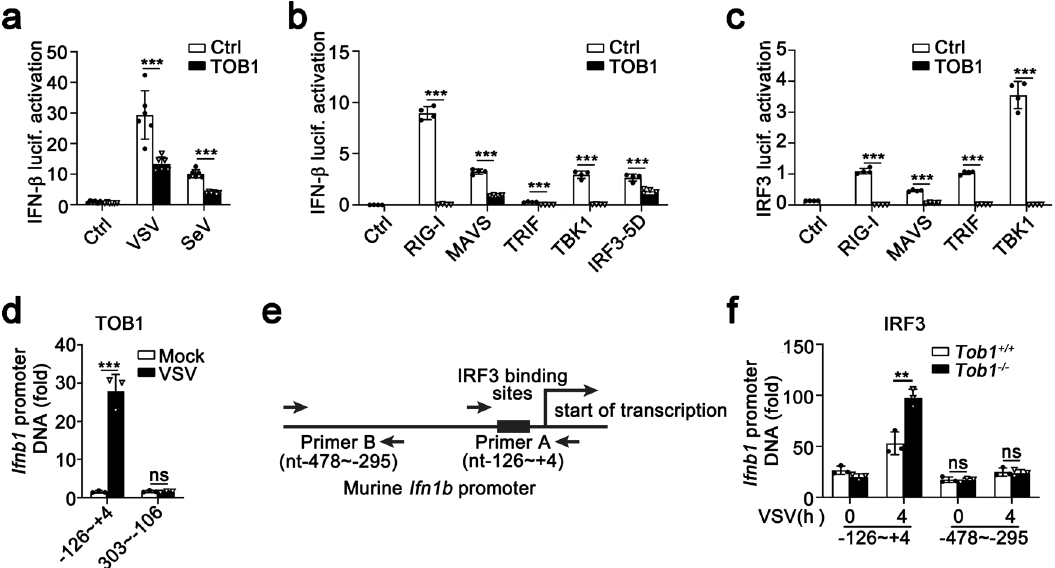
Fig. 4 TOB1 inhibits IRF3 binding to Ifnb1 promoter. a Luciferase activity analysis of HEK293T cells transiently transfected with IFN- β reporter plasmid together with TOB1 expression plasmid or empty vector(ctrl) after being infected with VSV or SeV. b , c Luciferase activity analysis of HEK293T cells transiently transfected with IFN- β ( b ) or IRF3 ( c ) reporter plasmid and adaptor plasmids as indicated, together with TOB1 expression plasmid or empty vector(ctrl). d ChIP-qPCR analysis of TOB1 binding at Ifnb1 loci in VSV-infected mouse primary peritoneal macrophages (PMs). e IRF3-binding site in the murine Ifnb1 promoter. Filled arrows, primers used for ChIP-qPCR assay. f Tob1 + / + or Tob1 − / − mouse PMs were infected with VSV, and then prepared for ChIP-qPCR assay performed using an anti-IRF3 antibody. All data are shown as the means ± SD. Signi fi cance was determined by unpaired two-tailed Student ’ s t -test: ** p < 0.01; *** p < 0.001. Data are shown as a representative result from three independent experiments. ( n = 4 in a – c ; n = 3 in d and f